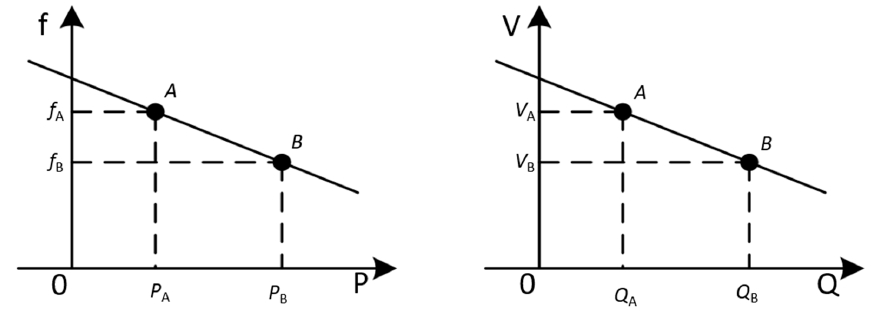
Figure 8. Droop Figure 8. Droop control.